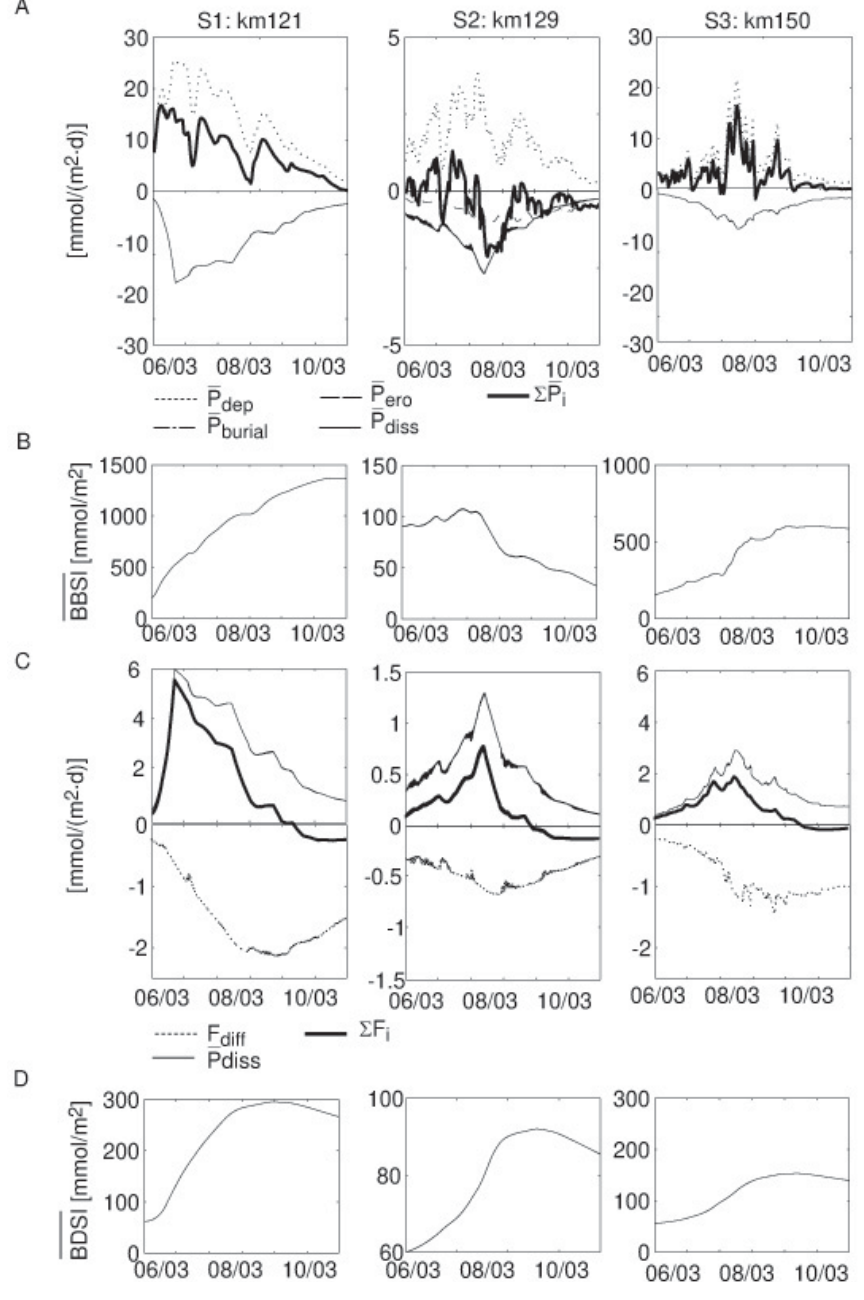
Fig. 8. Temporal evolution of (A) depth-integrated deposition flux P dep , erosion flux P ero , burial flux P burial , dissolution rate P diss and net rate P i P i , (B) depth-integrated biogenic silica content BBSI, (C) depth-integrated dissolution rate P diss , diffusive flux F diff , net rate of silica production/consumption and (D) depth-integrated dissolved silica concentration BDSI at three sites (S1, S2, S3, see Fig. 1) in the freshwater tidal reaches of the Scheldt. Simulation results correspond to the system scale parameter set (Table